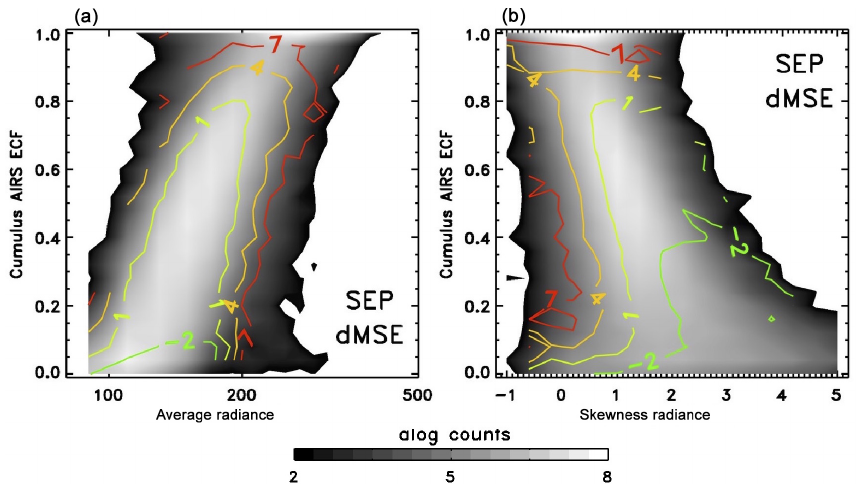
Figure 9. Joint PDFs of visible radiance average (left) and skewness (right) versus ECF for the SEP with dMSE depth as the overlay field. Other regions are very similar and are not shown for reasons of